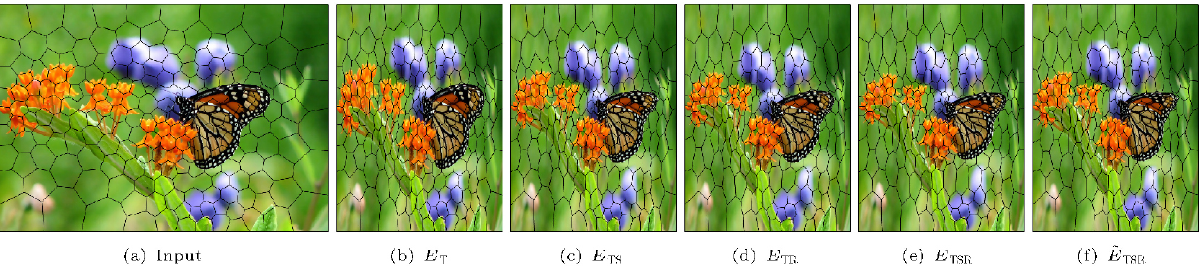
Fig. 6 Results using different deformation energy functions; there are 200 elements and 1900 DOFs in our warping representation. (a) Input. (b–f) Warping results by optimizing the energy functions in Eqs. (11) and (14)–(17),